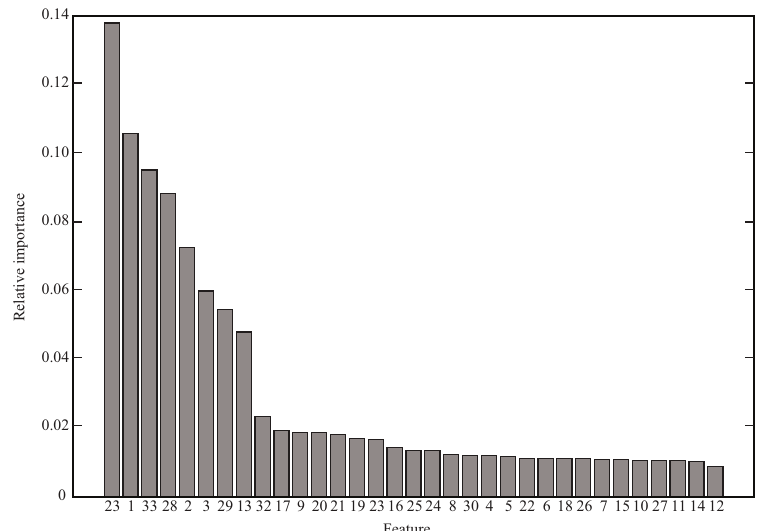
Figure 19. Relative importance of Features for the random forest